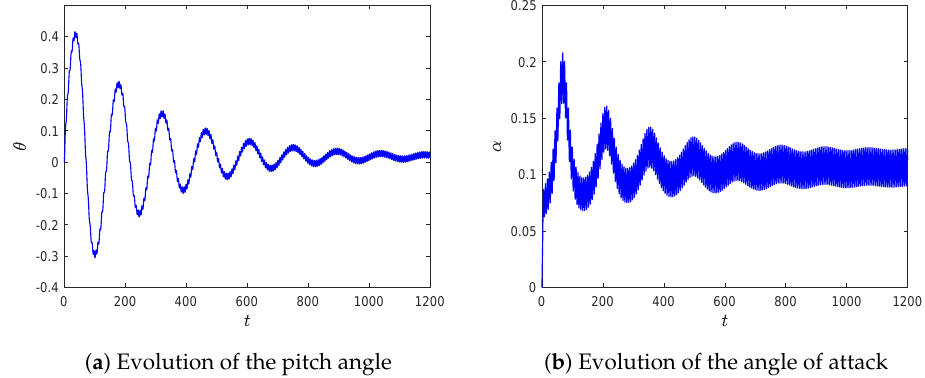
Figure 3. Evolution of θ ( a ) and α ( b ) with non − dimensional time. Frequency